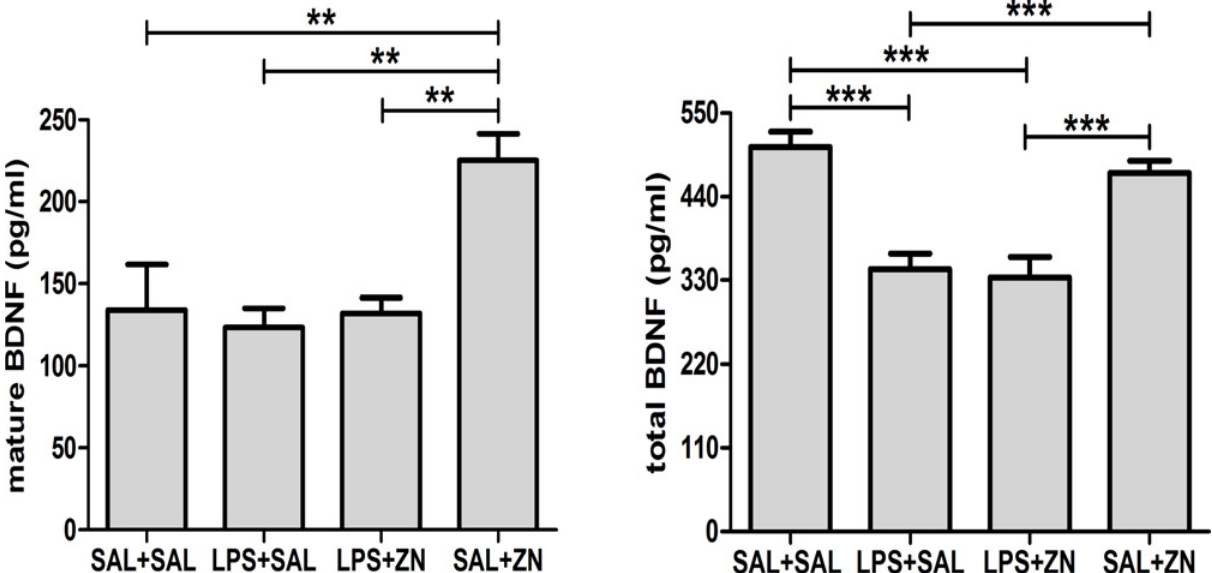
Fig 4. BDNF. Effects of LPS (100 μ g/kg) and zinc (ZnSO 4 ; 2 mg/kg) on mature and total BDNF plasma levels in adult male rats after a restraint stress challenge. SAL+SAL, saline injection followed by another saline injection 1 h later; LPS+SAL, LPS injection followed by a saline injection 1 h later; LPS+Zn, LPS injection followed by a zinc injection 1 h later; SAL+Zn, saline injection followed by a zinc injection 1 h later ( n = 10 per group). ** p < 0.01, *** p < 0.0001 (one-way ANOVA followed by the Tukey test). The data are expressed as the mean ±